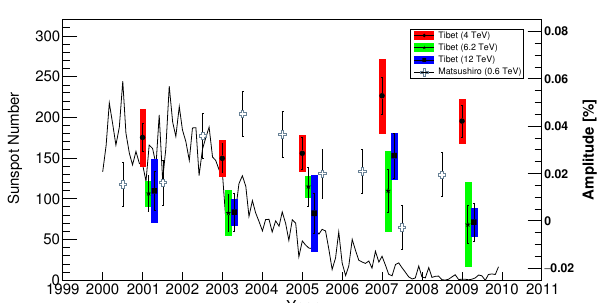
Figure 1: The amplitudes of the “additional” anisotropy observed by the Tibet experiment at 4.0 TeV (solid circles), 6.2 TeV (solid pentagrams) and 12 TeV (solid squares), along with Matsushiro’s results at 0.6 TeV (open crosses). Error boxes for the Tibet experiment indicate systematic errors obtained from analyzing the same data in the extended-sidereal time frame, while the error bars are statistical. The errors of Matsushiro’s results are statistical only. The gray line indicates the monthly mean sunspot number.